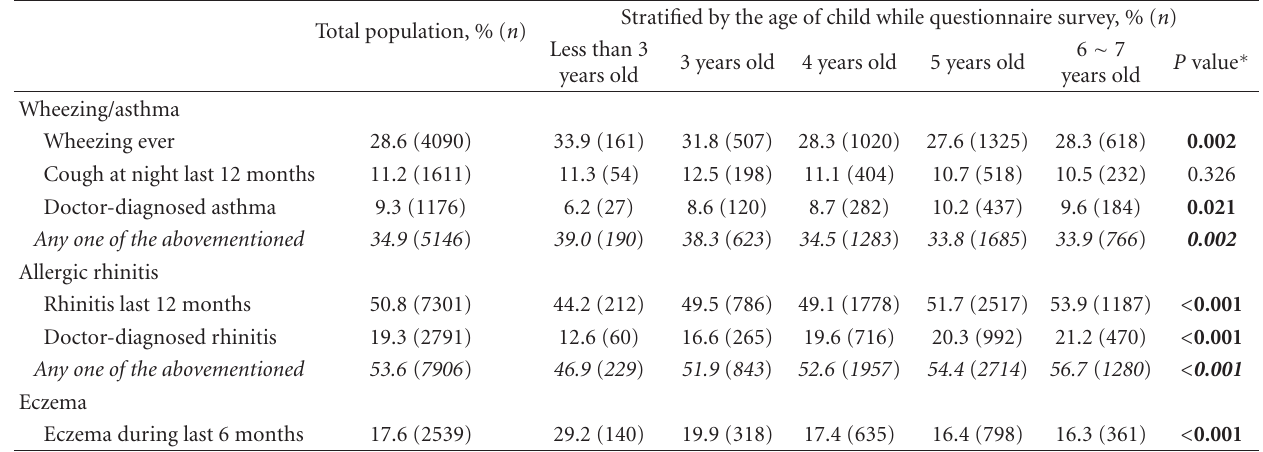
Table 2: Prevalence of diseases or symptoms among study